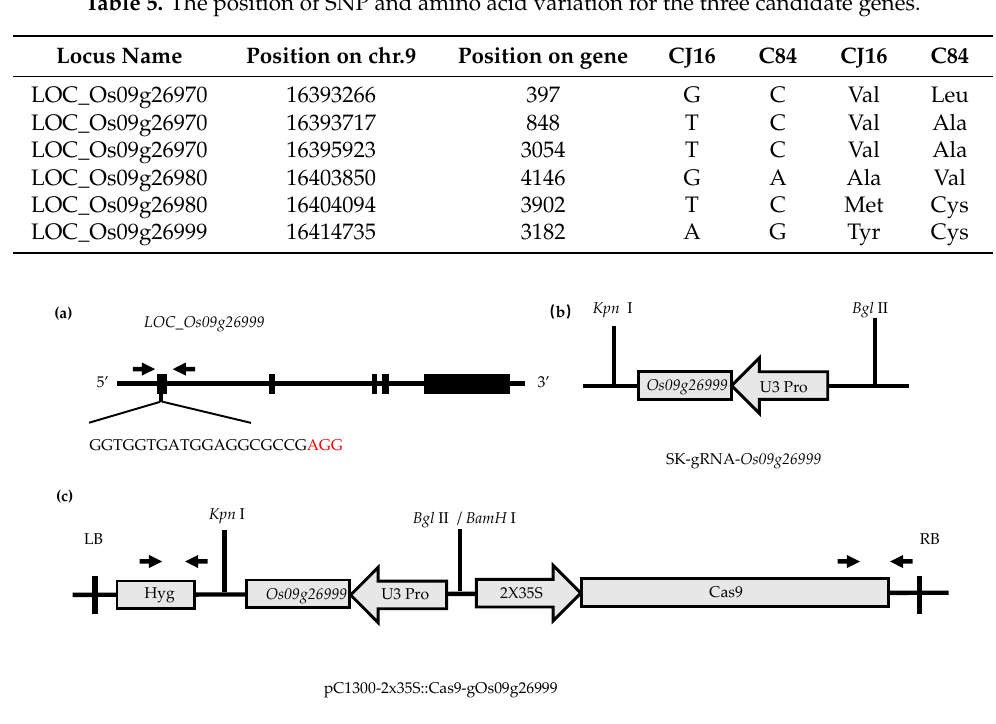
Table 5. The position of SNP and amino acid variation for the three candidate genes.